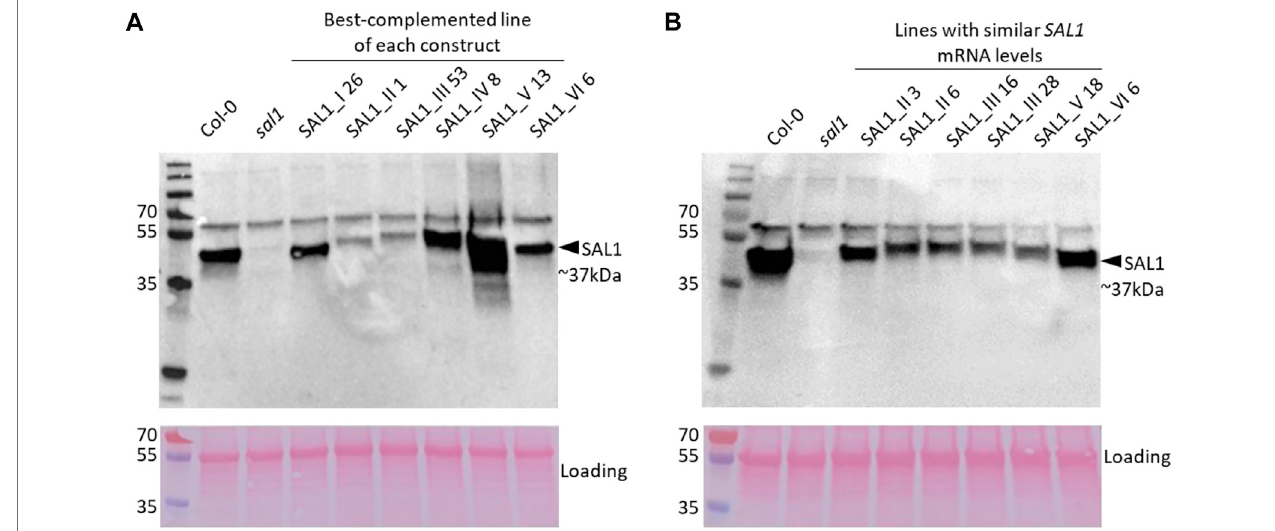
FIGURE 9 | SAL1 protein levels in best-complemented sal1 lines expressing SAL1 in different subcellular compartments and in complemented sal1 lines expressing similar SAL1 mRNA levels. SAL1 protein levels were analyzed in total protein extracts of 25-day-old rosette leaves from the best-complemented line of sal1 expressing the different constructs I – VI (A) and diverse complemented sal1 lines with similar SAL1 mRNA levels ( ∼ 10-fold overexpression compared to Col-0) (B) . Immunoblotting was performed with an anti-SAL1 antibody and a horseradish peroxidase (HRP)-conjugated secondary antibody against 20 µg total protein per sample. The SAL1 protein was detected at approximately 37 kDa, with no SAL1 protein in the sal1 mutant sample, as expected. A higher band at 55 kDa is most likely the result of nonspeci fi c antibody binding to Rubisco ( upper panels ). The blots were subsequently stained with Ponceau S and re-imaged to evaluate equal loading between samples ( lower panels ). In both (A) and (B) , the upper and lower panels were generated from the same blot that was independently imaged twice after incubation with HRP chemiluminescence substrate and Ponceau S,